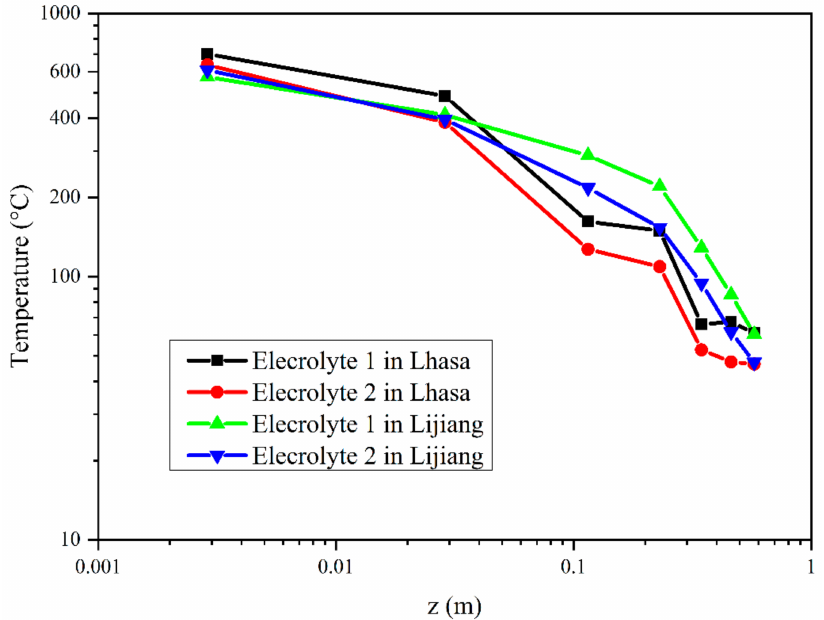
Figure 7. The average fire centerline temperatures at different thermocouple positions (height above the sample liquid level) of the two samples under different pressures during the stable combustion stage.